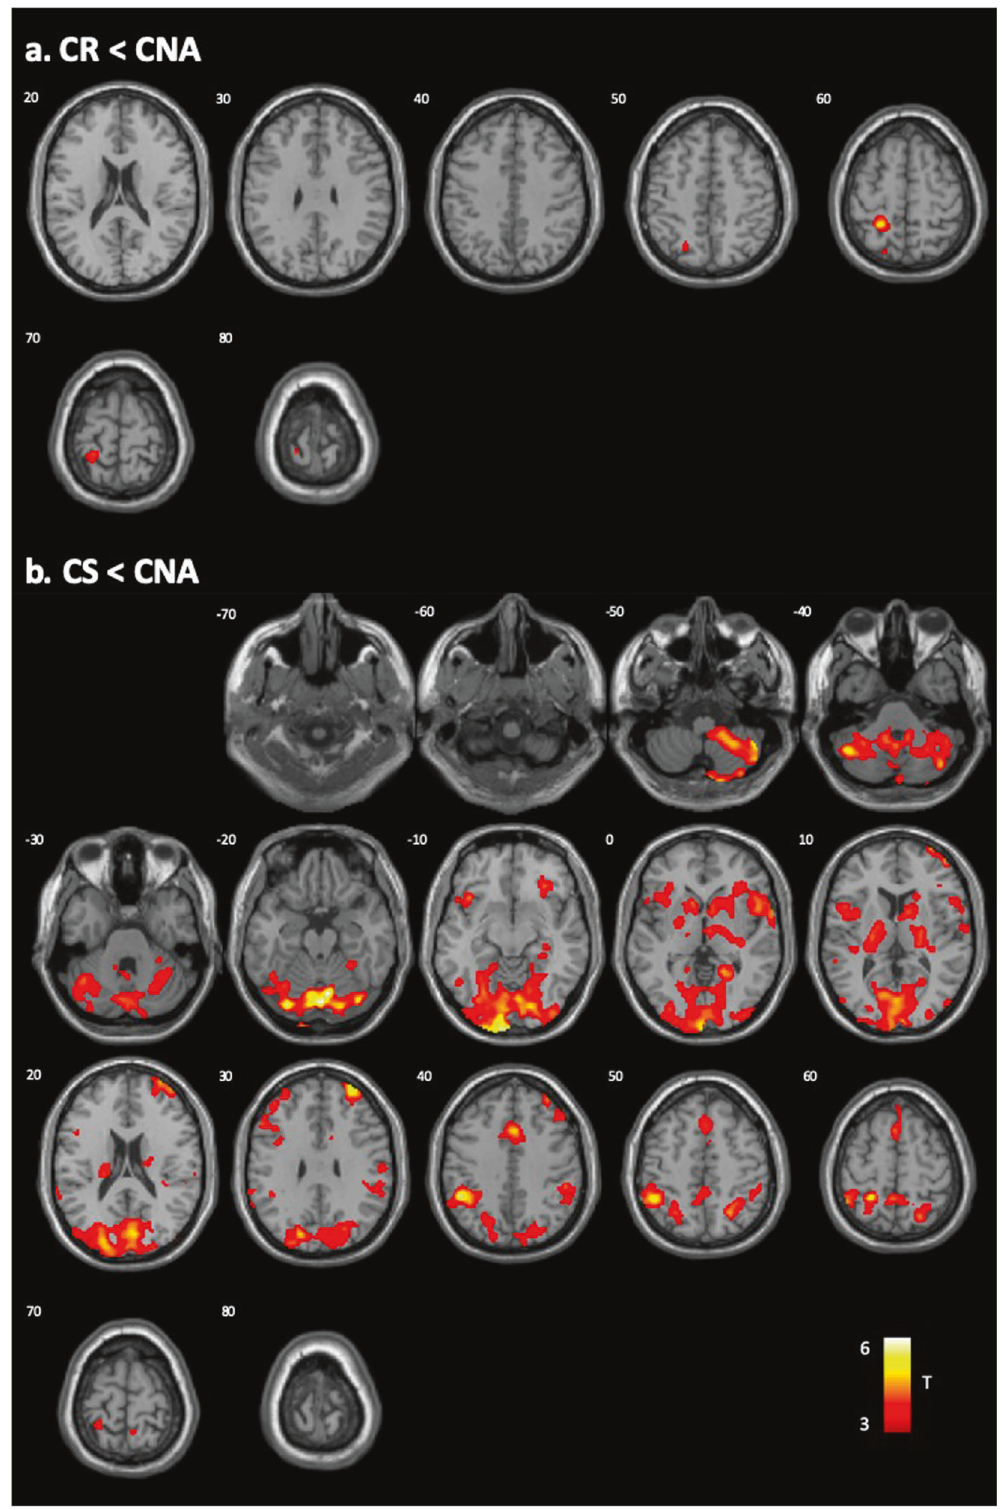
Fig. 3 Brain regions showing reduced amygdala-based resting-state functional connectivity between subtypes. a CR Compulsive Reactive subtype compared to the CNA Compulsive Non-Avoidant subtype, and b CS Compulsive Stressed subtype compared to the CNA subtype. Colored areas indicate signi fi cant regions after family-wise correction at the cluster level ( P FWE <